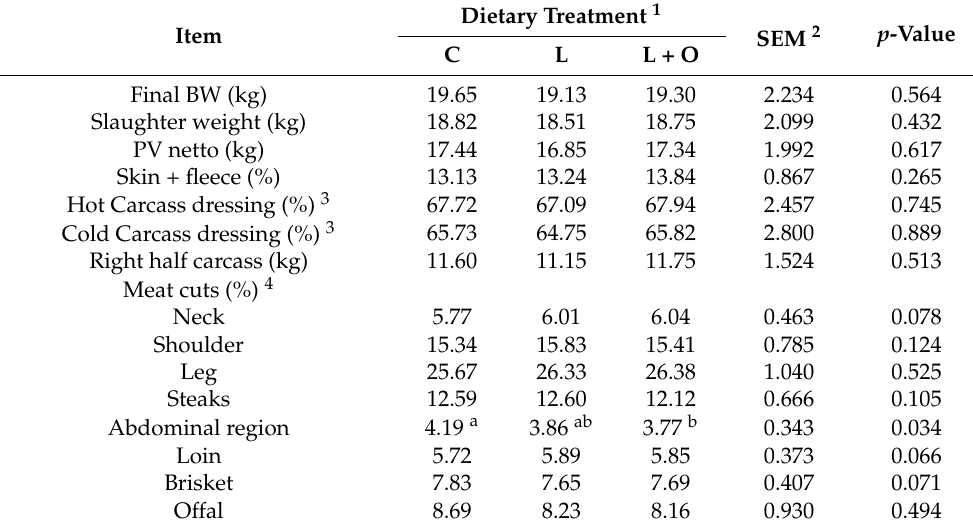
Table 5. Effect of diet on slaughtering data of lambs